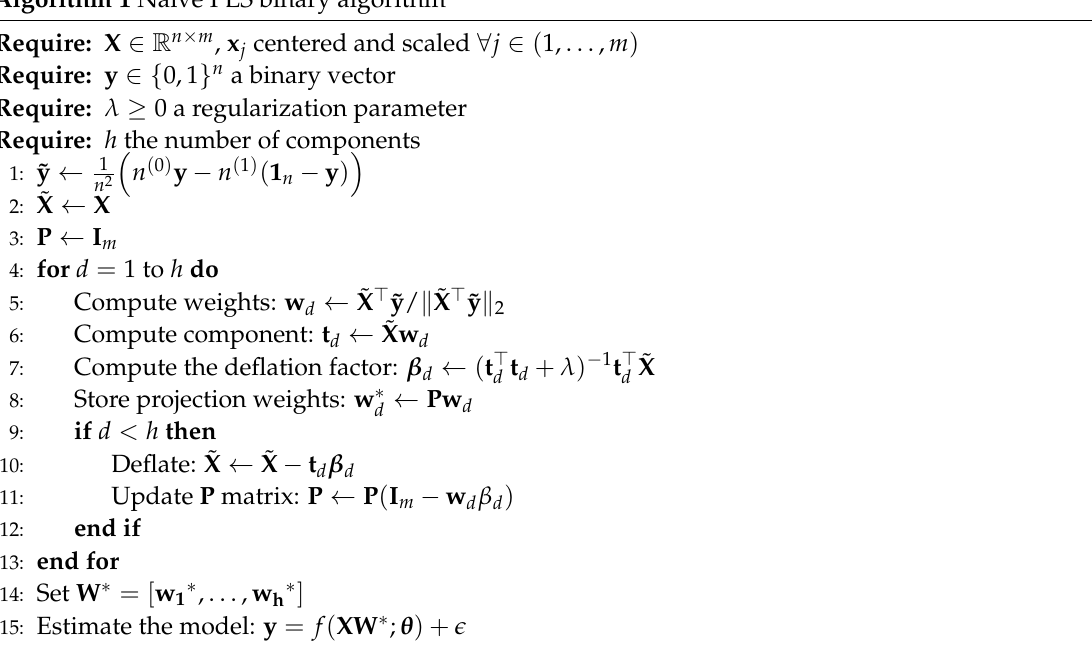
Algorithm 1 Naive PLS binary